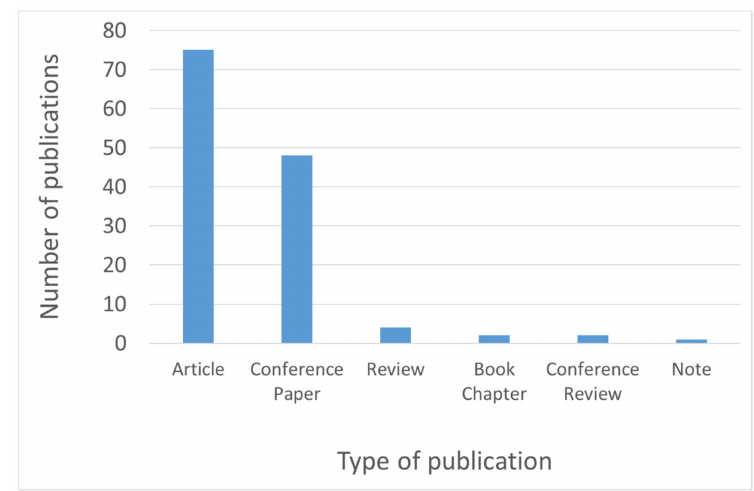
Figure 4. Type and number of publications.